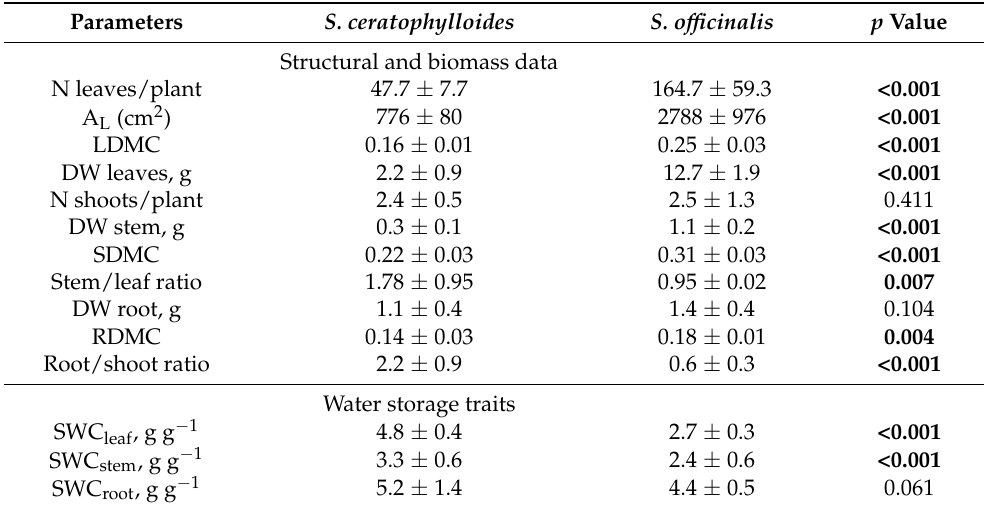
Table 1. Mean values ± SD of structural and biomass data and water storage traits as measured in well-watered samples of S. ceratophylloides and S. officinalis plants ( n = 10). Differences between species were statistically analyzed and corresponding p values are